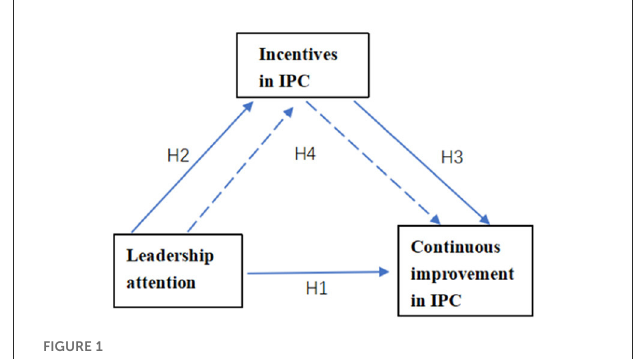
FIGURE1 The theoretical hypothesis